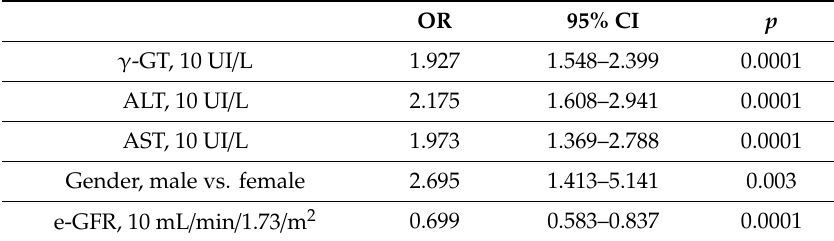
Table 4. Multiple logistic analysis of endothelial dysfunction.